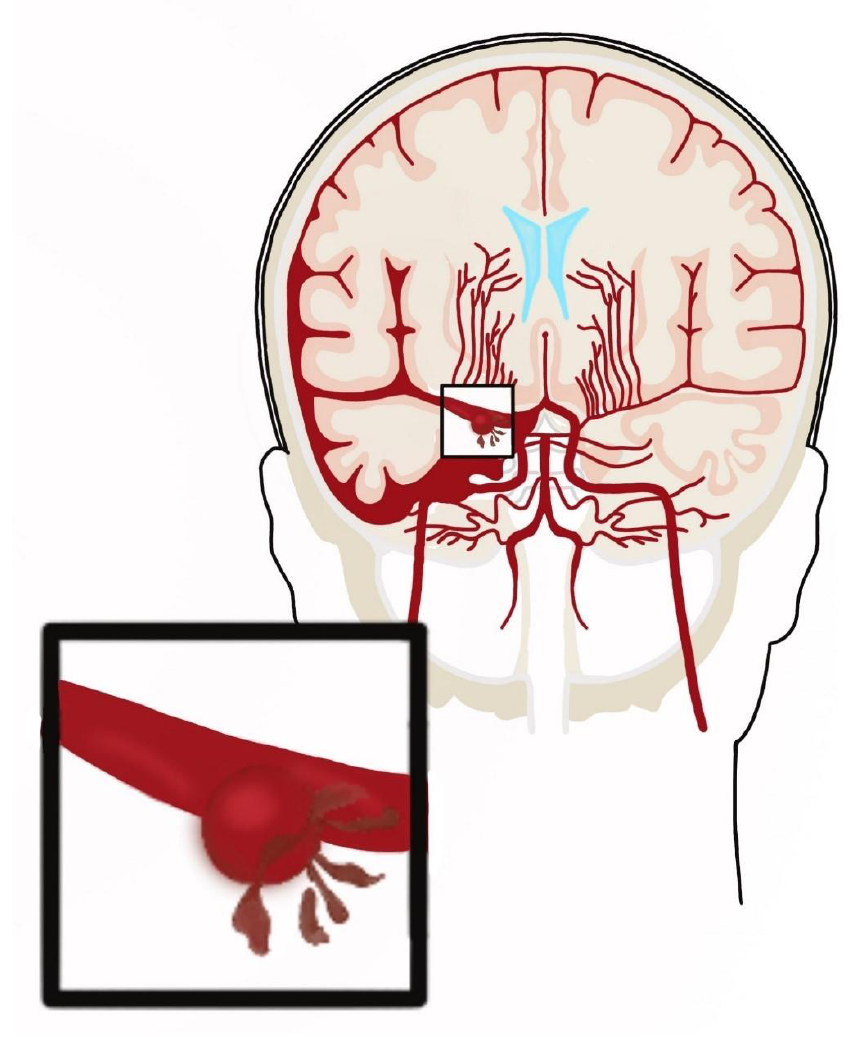
Figure 2. Aneurysmal subarachnoid hemorrhage.